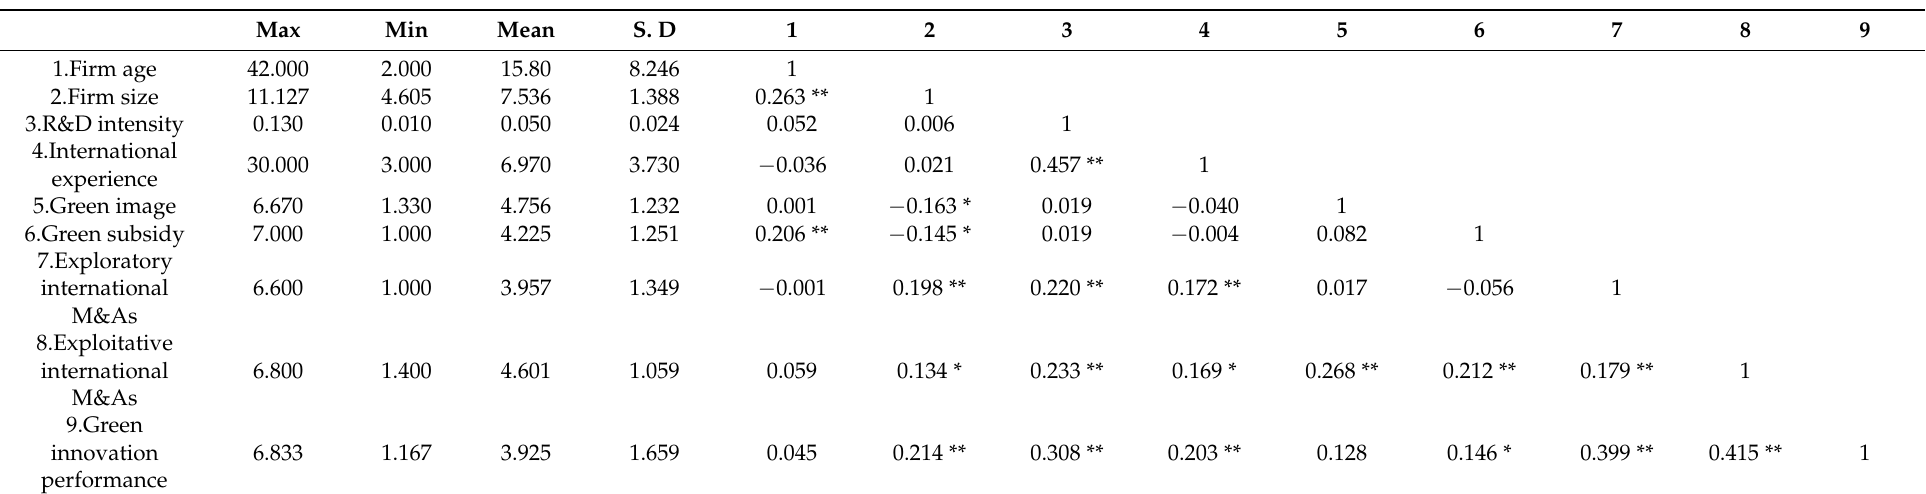
Table 2. Means, standard deviations, and